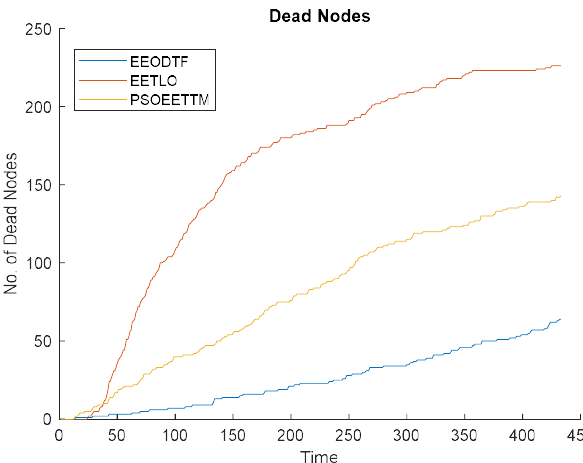
Figure 11. Number of dead nodes vs. time.